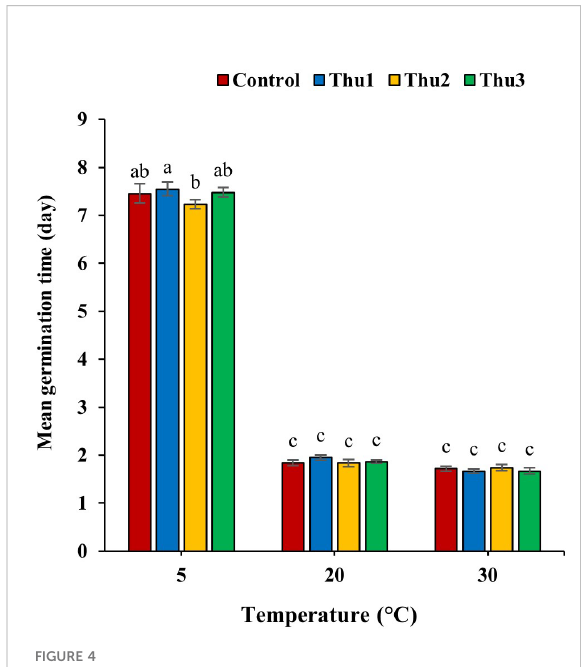
FIGURE 4 Effects of temperature and Th17 concentrations on mean germination time. Thu1: 10 -7 M Th17, Thu2: 10 -9 M Th17, Thu3: 10 - 11 M Th17. Each bar represents mean ± standard error (n=8). Means with the same letters are not signi fi cantly different ( p <